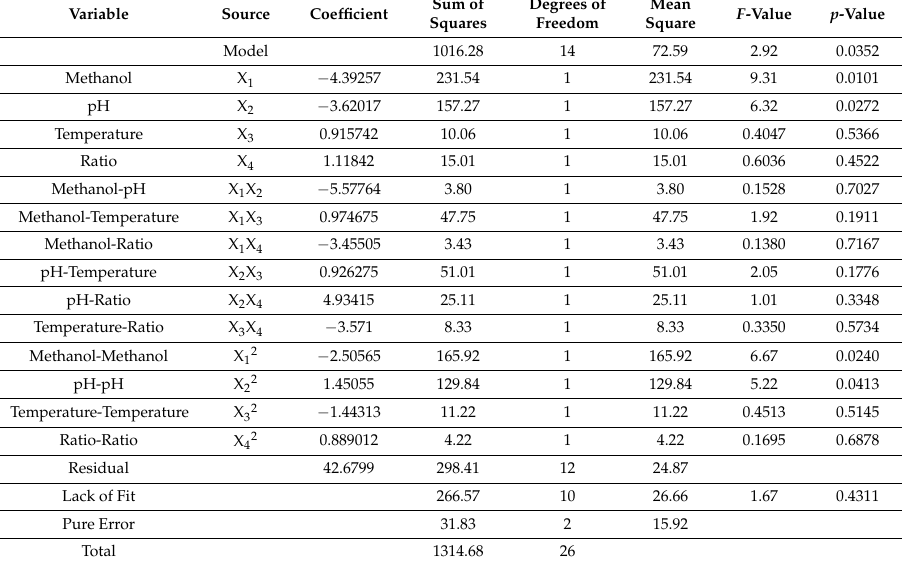
Table 1. Analysis of variance of the quadratic model adjusted to the extraction of total phenolic compounds. The studied ranges for each parameter were: methanol (50–100%), pH (2–7),